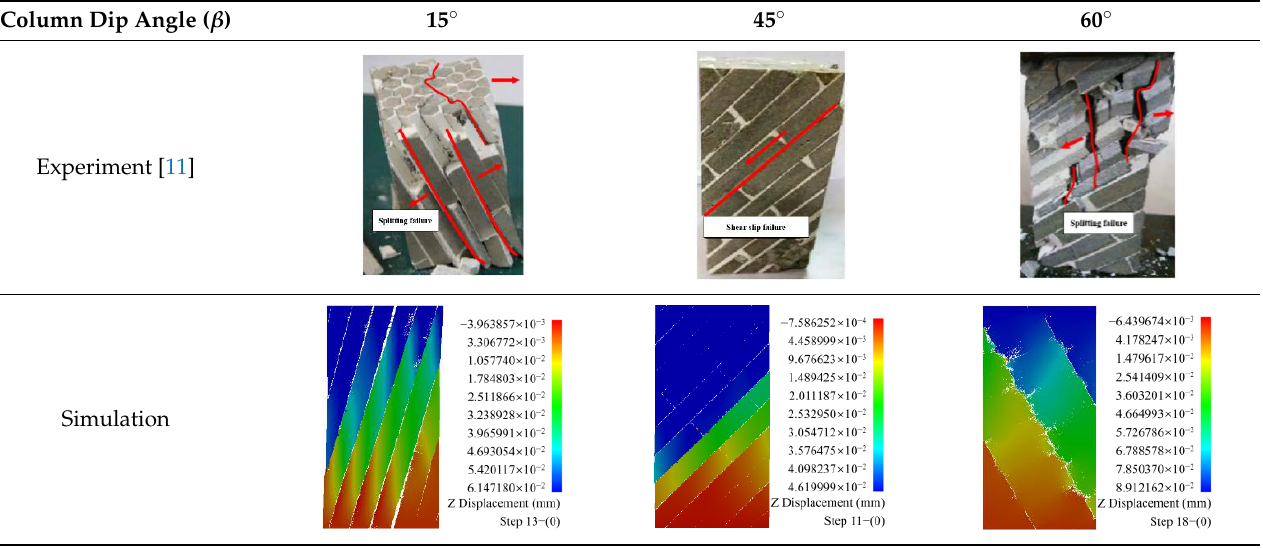
Table 3. The failure modes obtained by simulation and experiment [11].